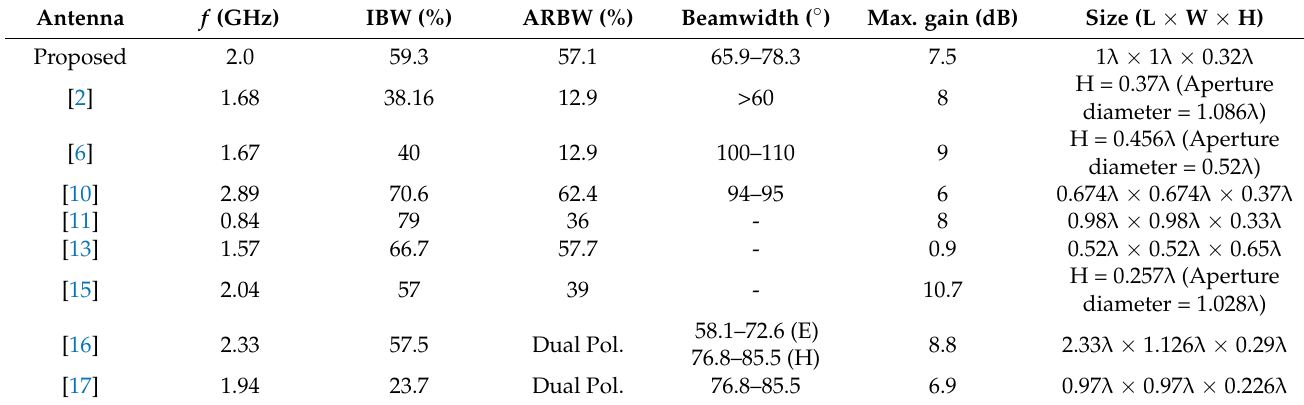
Table 1. Comparison of the existing printed cross-dipole and proposed antennas operating at L-/S-bands. Antenna f